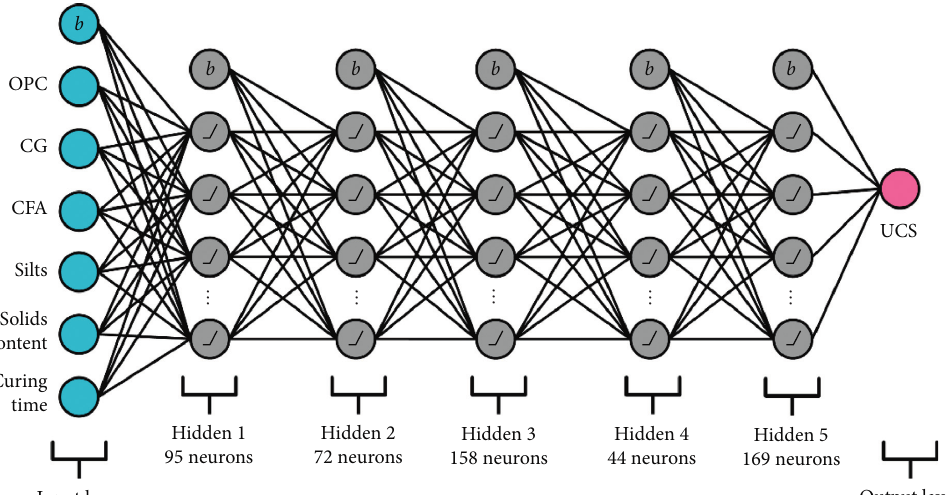
Figure 13: The optimum DNN architecture.